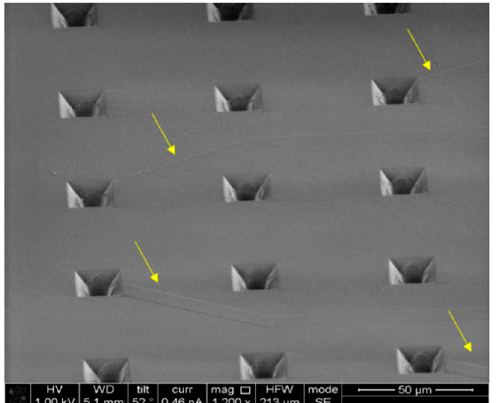
Figure 4. Fabricated NOA81 microsieve using spin-coating shows a successful replica with the nanometer high features of the original μ SEA (yellow arrows).